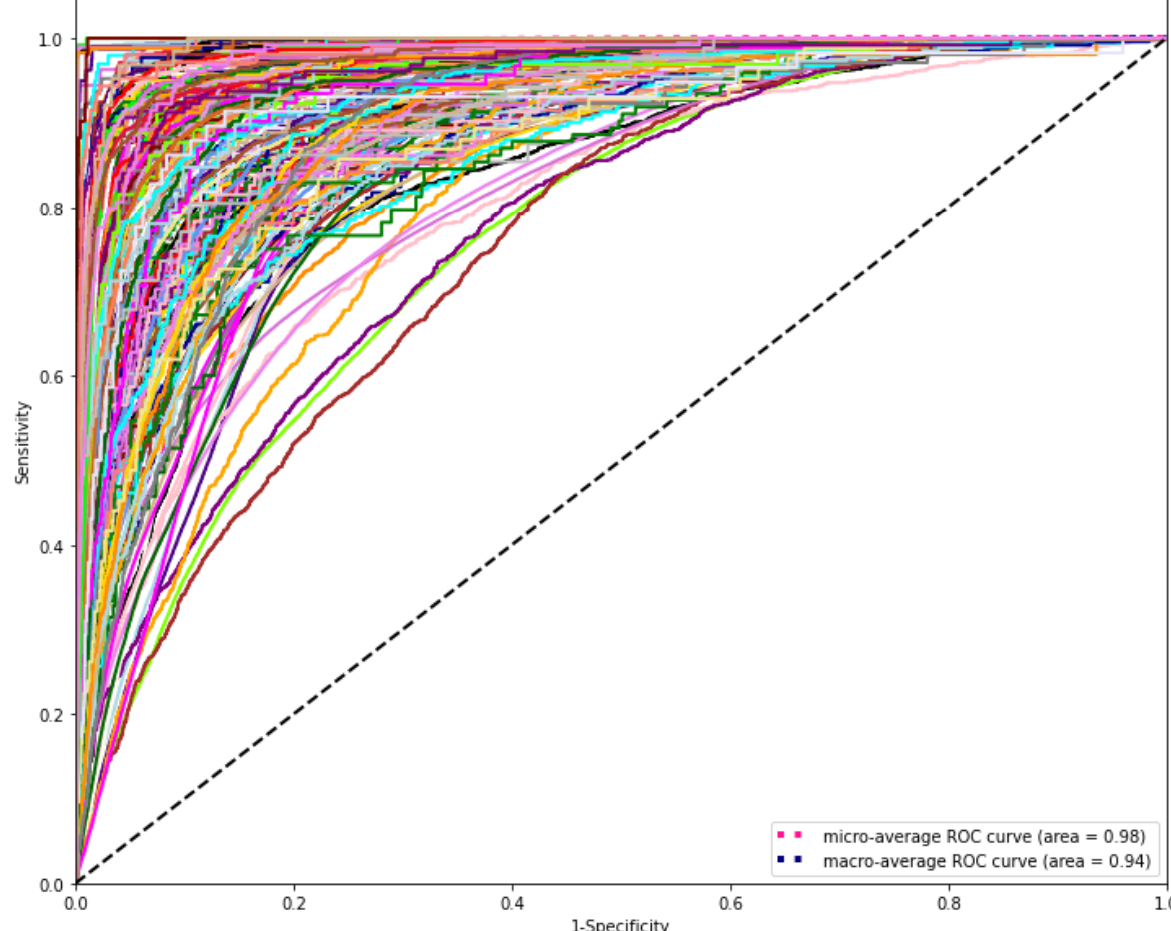
Figure 6. Receiver operating characteristic (ROC) curves of the deep learning model for predicting laboratory tests. The range of AUROC was between 0.76 and 1 (Supplementary Table S1). The highest AUROC 1 was HIV viral loading test and the lowest AUROC 0.76 was for CBC-III (WBC, RBC, HB, HCT, and MCV).